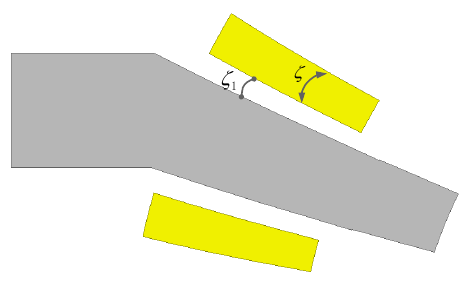
Figure 13. Parameters illustration of stator coil.